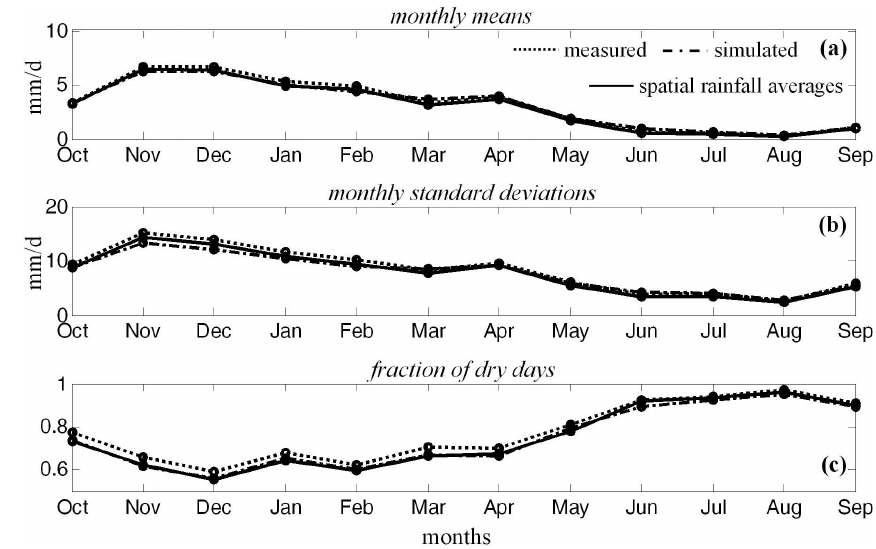
Fig. 15. Same as Fig. 14 but for the case when using point rainfall measurements from the location of Moira (point C in Fig. 2).